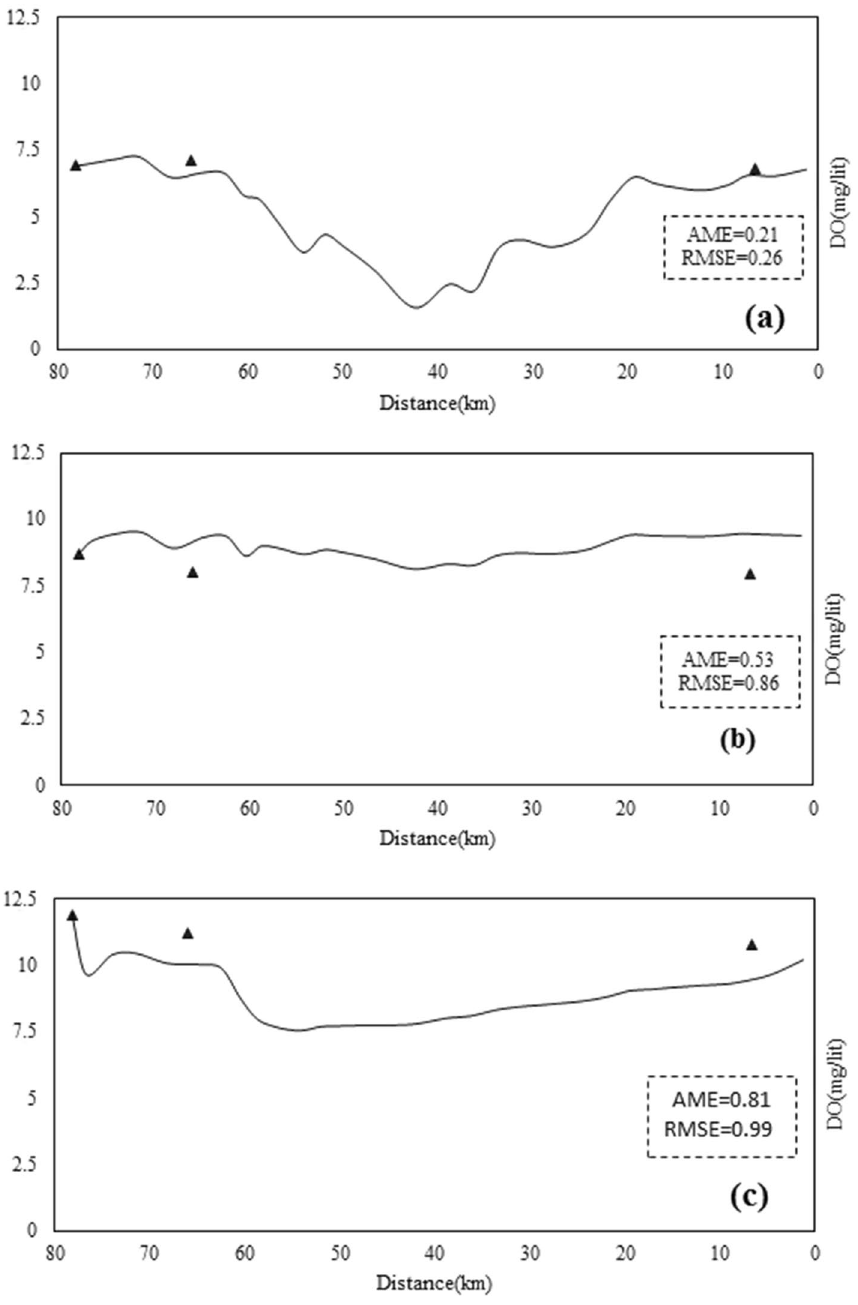
Figure 8. Total dissolved oxygen content of Sarouq River in ( a ) spring, ( b ) autumn, ( c ) winter after